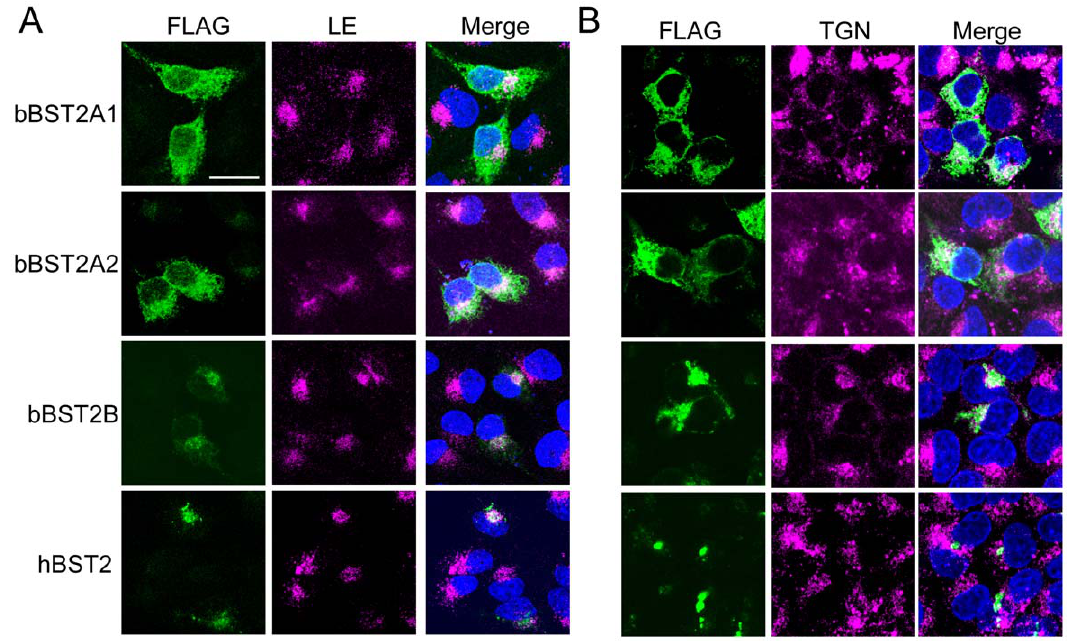
Figure 5. Co-localization of bovine BST-2 to the late-endosome (LE)/trans-Golgi network (TGN) compartments. FLAG-tagged bBST-2s expressed in HeLa cells were stained with FITC-conjugated anti-FLAG antibody (left panels) and then observed by confocal laser microscopy. LE or TGN was stained with anti-CD63 antibody (A) or anti-TGN46 antibody (B), respectively. Merged images of bBST-2s (green), organelle marker (red), and nuclei (blue) are shown in the right panels.